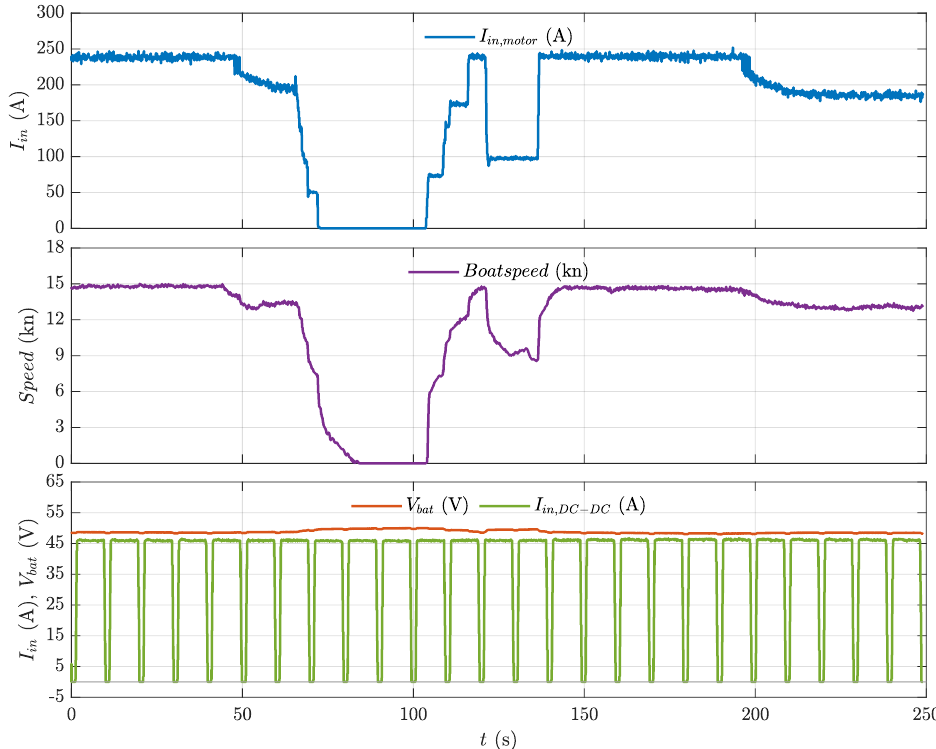
Figure 22. Data acquired during the sea trail depicting the motor current transients ( top ), boat speed in knots ( middle ), constant DC-DC converter input current, and battery voltage ( bottom ). One knot equals 1.85 km/h.